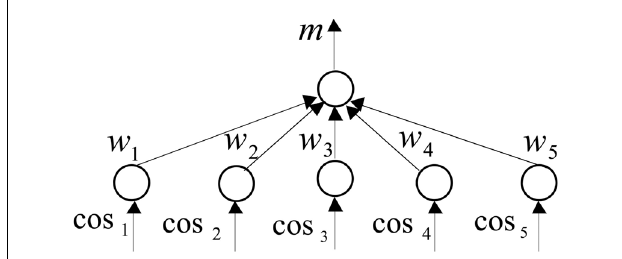
FIGURE 4 |A neural network that integrates five LSA cosines to classify targets from